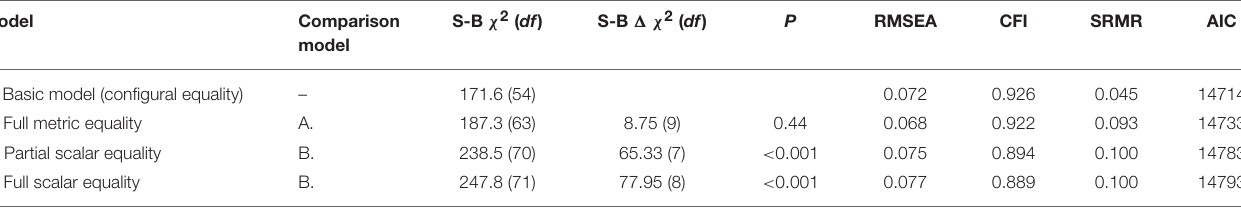
TABLE 5 | Tests of PHQ-9 measurement equivalence across gender. Model